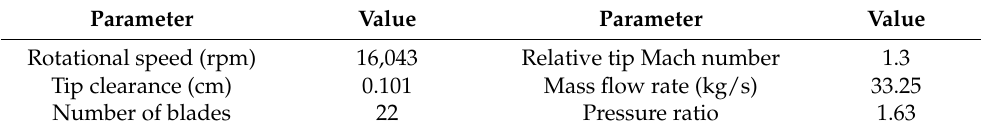
Table 1. Specifications of Rotor 67 [33].